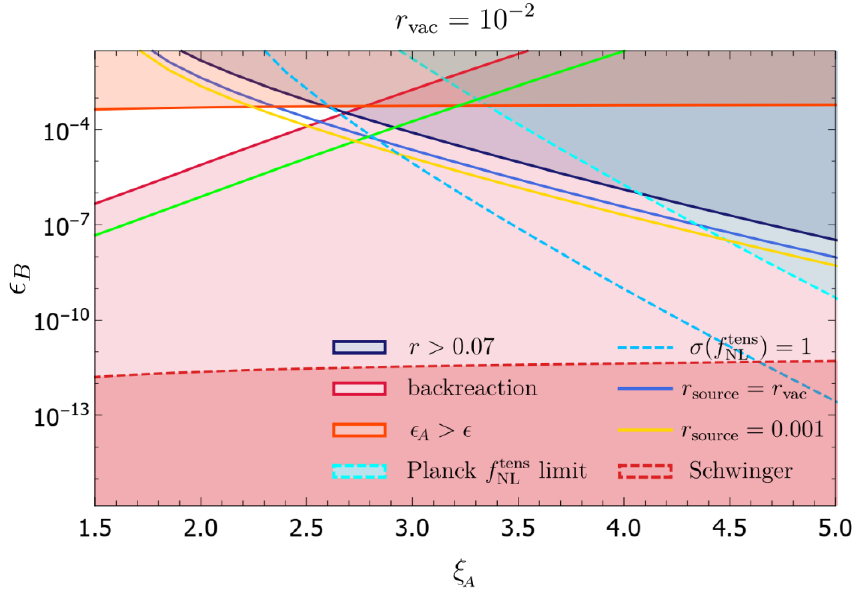
Figure 12 . Excluded parameter space of the massless models with r vac = 10 (cid:0) 2 . The blue shaded area is excluded by the tensor-to-scalar ratio, the light red area by the large backreaction ( B A > 10 (cid:0) 2 ), the orange area by the inconsistent slow-roll condition ( (cid:15) A > (cid:15) ), the cyan area by the tensor non-Gaussianity, and the dark red area by the Schwinger pair-creation of scalar (cid:12)elds. The blue and yellow lines show r source = r vac and r source = 10 (cid:0) 3 , respectively, while the dashed cyan line shows f tens = 1. The green line corresponds to the amount of backreaction as large as B A = 0 : 1. NL (cid:15) The BICEP2/Keck and Planck (BKP) upper bound on the tensor-to-scalar ratio, r < 0 : 07 (95% C.L)